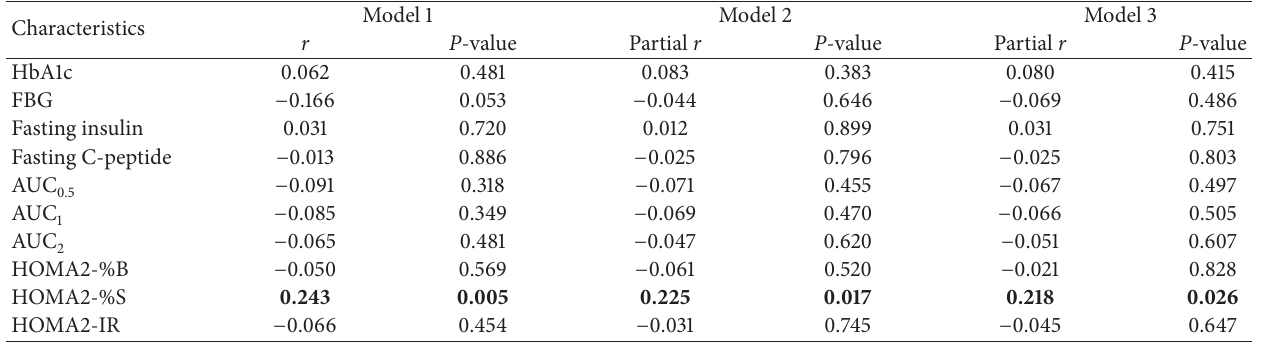
Table 4: Partial correlations between irisin levels and glucose-related variables in T2DM subjects.